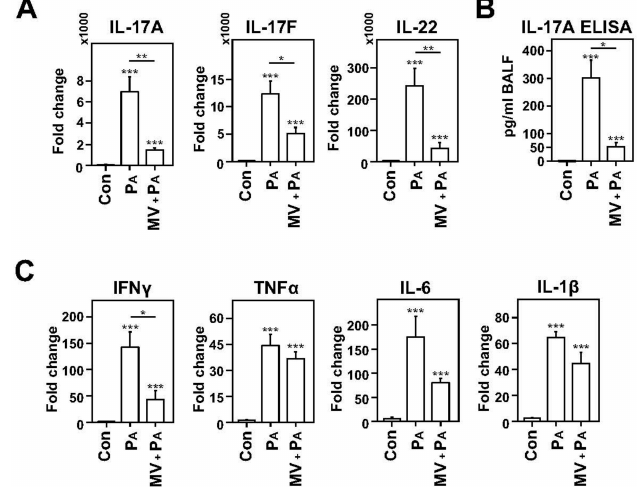
Figure 2. Dampening of proinflammatory T H 17 and, to a limited extent, T H 1 cytokines induced by infection in mechanically ventilated rats. ( A ) Lung transcript levels of IL-17A , IL-17F , and IL-22 are reduced in mechanically ventilated animals infected with Pseudomonas aeruginosa (MV + P A ) compared to non-ventilated, infected animals (P A ) euthanized after 24 h. ( B ) IL-17A protein measured in bronchoalveolar lavage (BAL) fluid was also reduced in MV + P A group compared to the P A group. ( C ) Similarly, lung transcript levels of T H 1 cytokines showed a declining trend for MV + P A group compared to the P A group, but these di ff erences were significant only for IFN- γ . ( A – C ) Data are presented as averages ± SEM; * p < 0.05, ** p < 0.01; and *** p < 0.001; asterisk above the error bars denotes significance against control group; n = 5–6 animals per